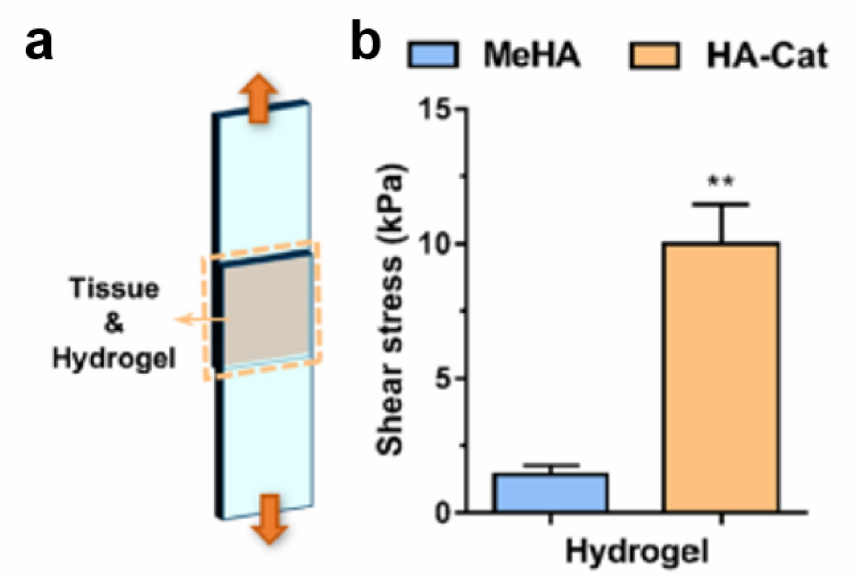
Figure 2. ( a ) Schematic illustration of a lap shear tissue adhesion test. ( b ) Average adhesive stress (kPa) of methacrylated HA (MeHA) and HA–catechol (HA-Cat) hydrogels (** p < 0.01). Reprinted with permission from [52]. Copyright © 2019